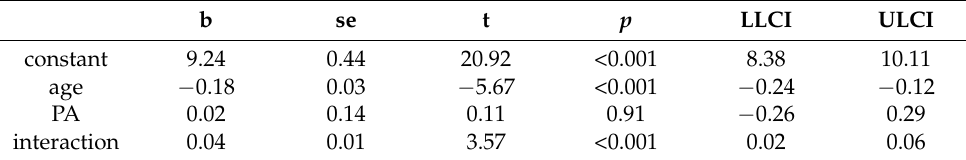
Table 5. Regression analysis of SWB on PA, considering the moderating effect of vulnerability.